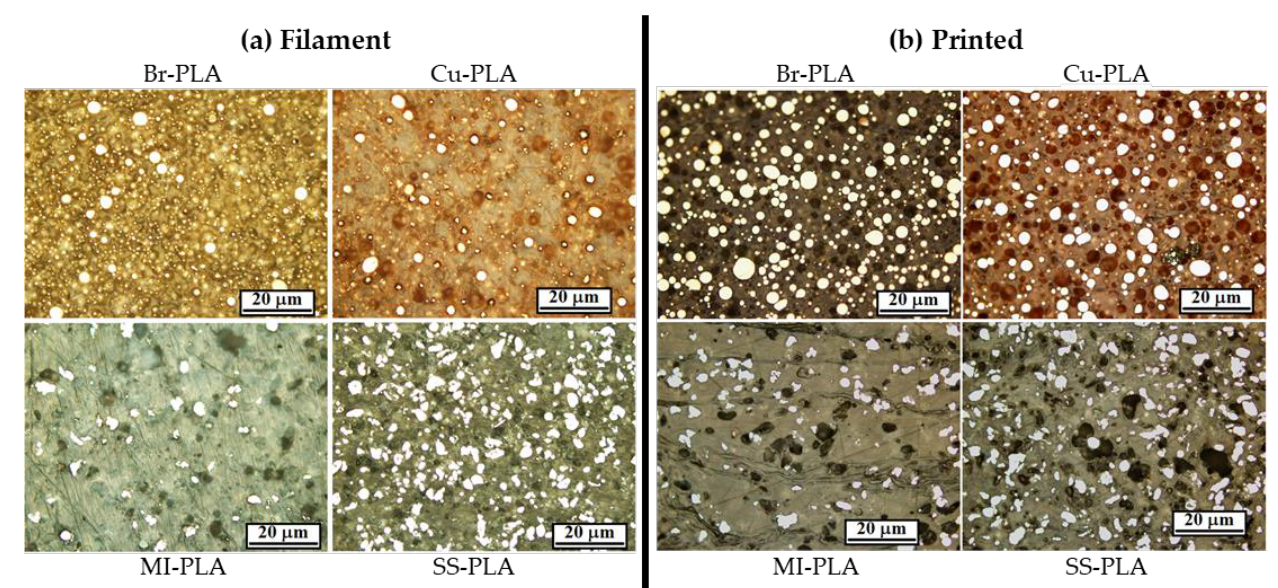
Figure 5. Micrographs of Br-PLA, Cu-PLA, MI-PLA, and SS-PLA ( a ) filaments before printing, and ( b ) parts after printing.